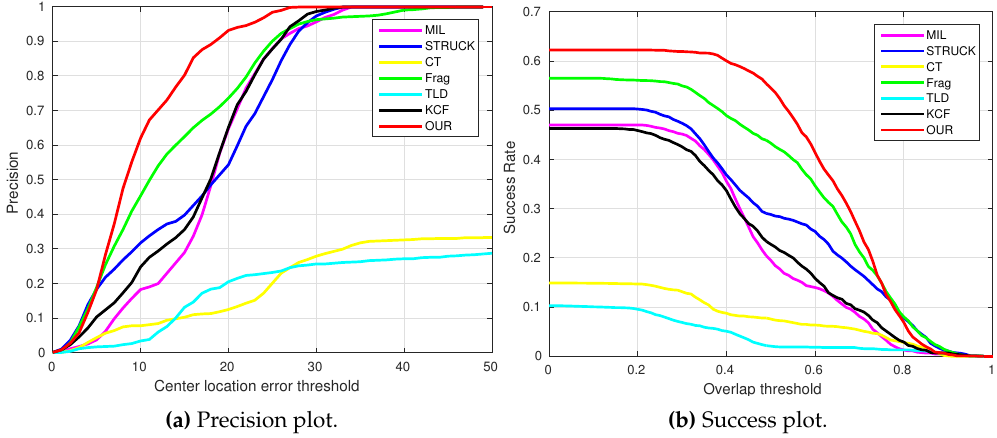
(a) Precision plot. (b) Success plot. Figure 16. Precision and success plots of all trackers with the People bw image sequence.